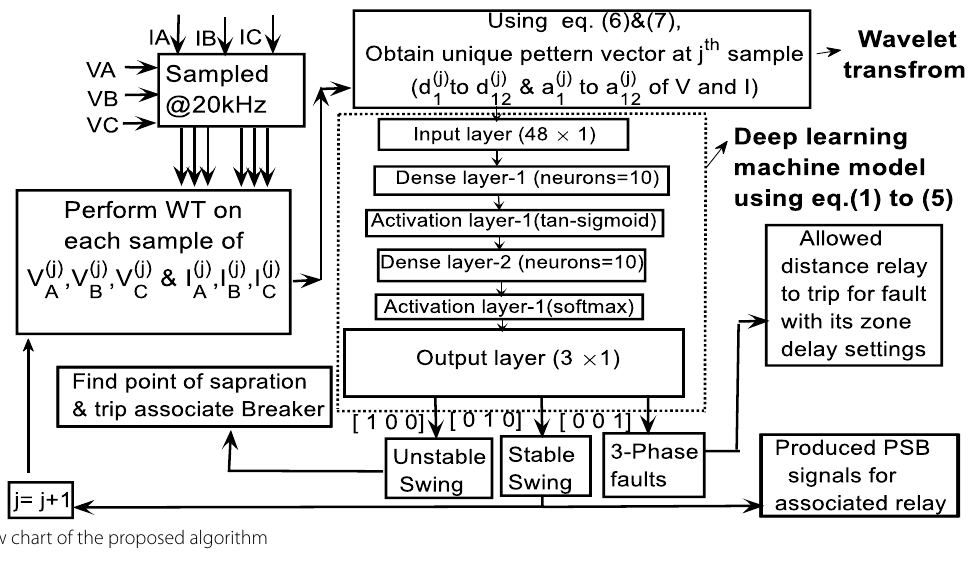
Fig. 7 A flow chart of the proposed algorithm